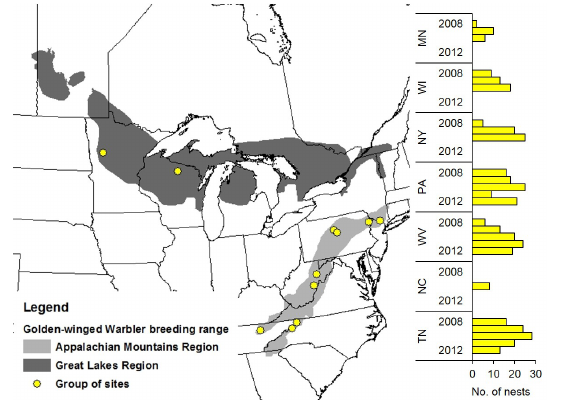
Fig. 1 . Sample sizes of nests by state (Minnesota